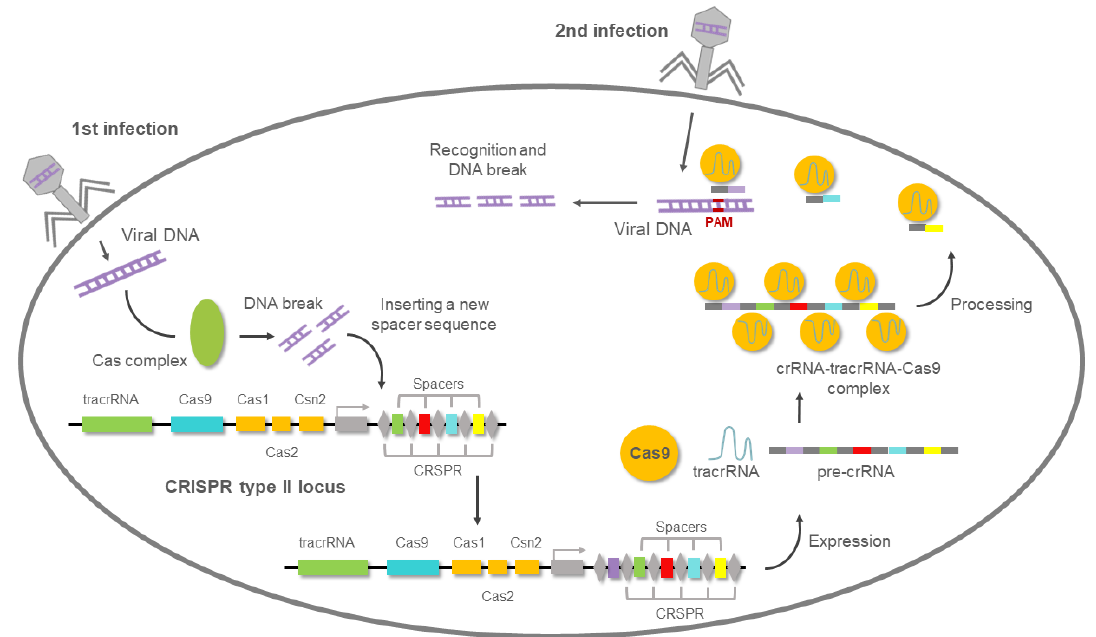
Figure 6. CRISPR (clustered regularly interspaced short palindromic repeats)-mediated adaptive immunity system presents in prokaryotes. After the first viral infection, the Cas complex excises the viral DNA, then introduces it into the bacterial genome. When the second viral infection occurs, a complementary RNA (crRNA) to that of the viral genome is used to guide the Cas9 nuclease to degrade the viral DNA.